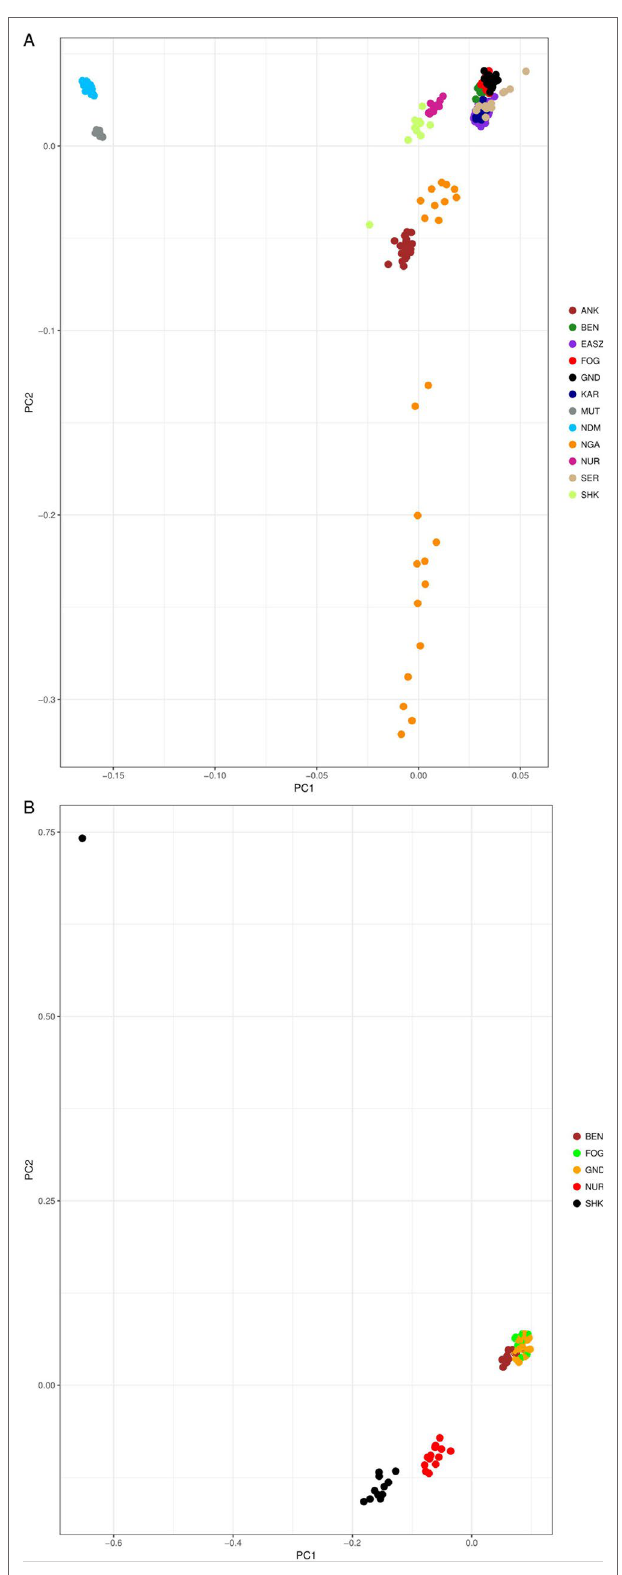
FIGURe 2 | PCA plots of the first two principal components showing the genetic relationship between cattle breeds. (A) PCA plot for all cattle breeds included in this study, and (B) PCA plot for the Ethiopian cattle breeds. ANK, Ankole; BEN, Benshangul; FOG, Fogera; GND,